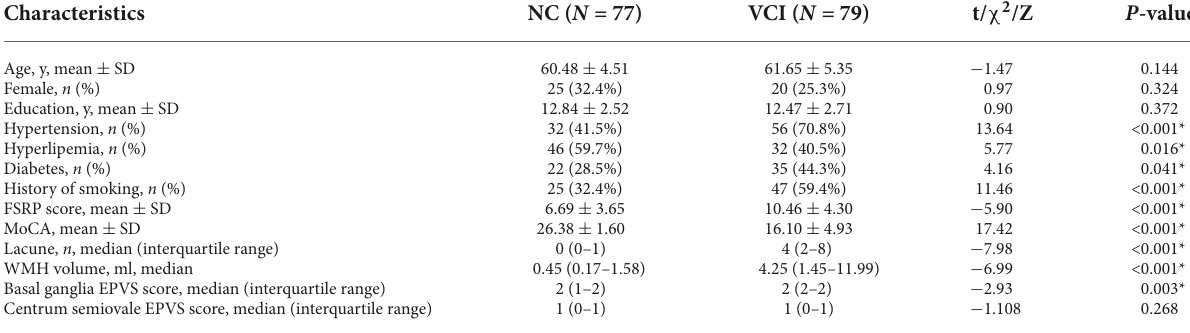
TABLE 1 Demographics and clinical characteristics.